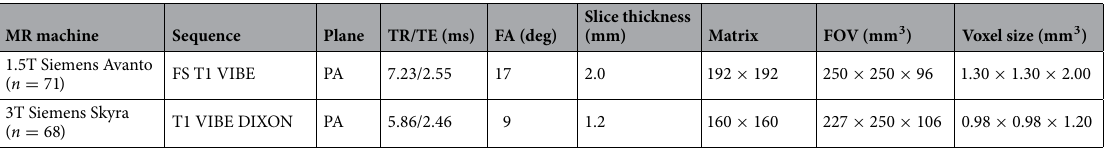
Table 2. MR acquisitions used in the project for segmentation of primary tumors in endometrial cancer. deg = degrees, mm = millimeter, ms=millisecond, FA = flip angle, FOV = field of view, PA = paraxial slice orientation, TE = echo time, TR = repetition time, VIBE = Volumetric Interpolated Breath-hold Examination, FS = fat